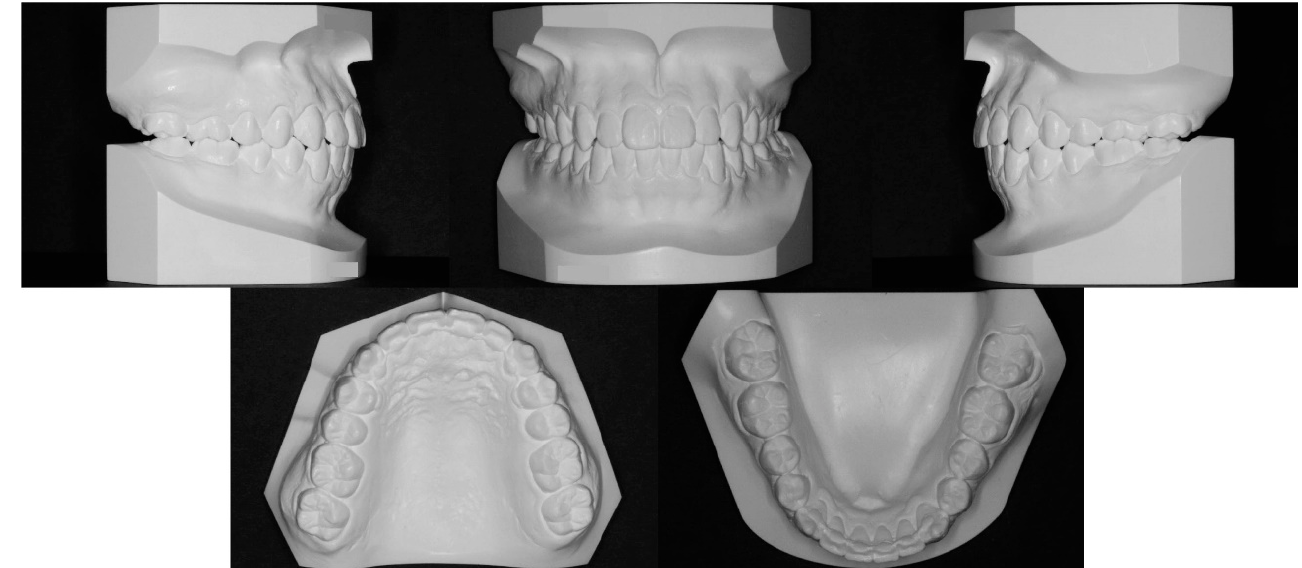
Figure 11. Two-year retention dental casts.